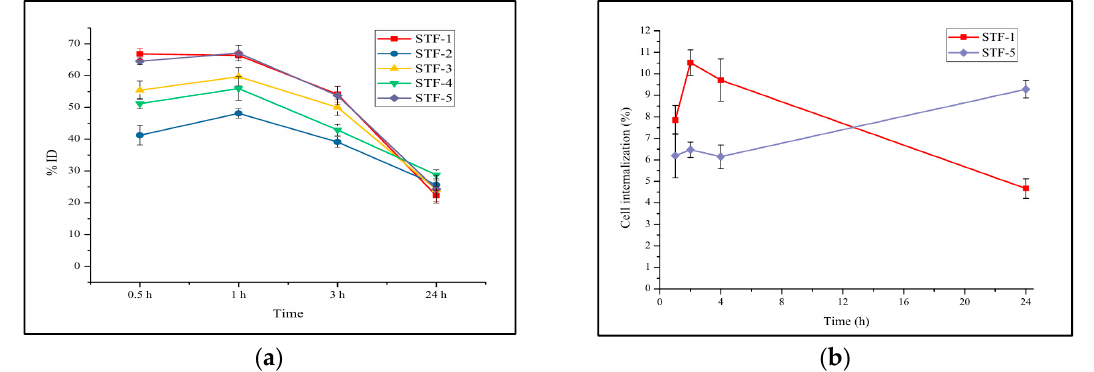
Figure 5. Results of ( a ) cellular uptake for STF-1~5 and ( b ) cell internalization for STF 1 and 5.